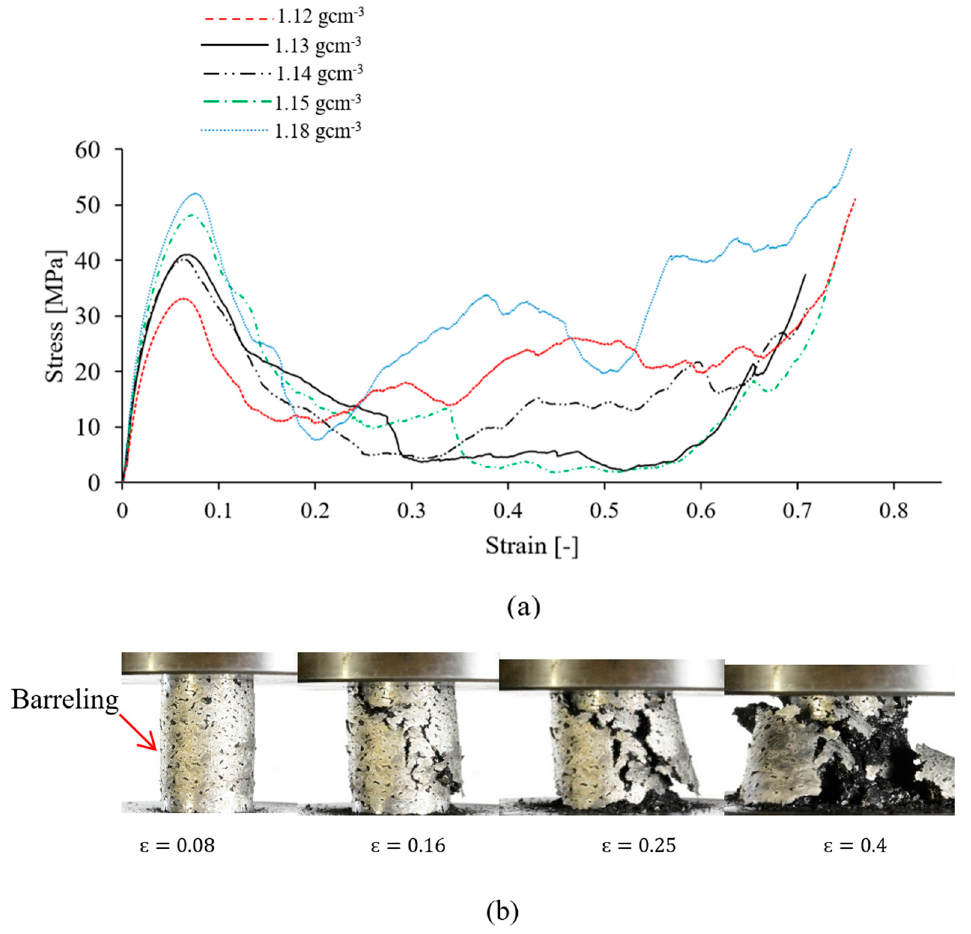
Figure 4. ( a ) Compressive stress-strain curves of AZ91–AC syntactic foams with different densities, and ( b ) macroscopic deformation of an AZ91/AC syntactic foam with a density of 1.15 gcm − 3 .